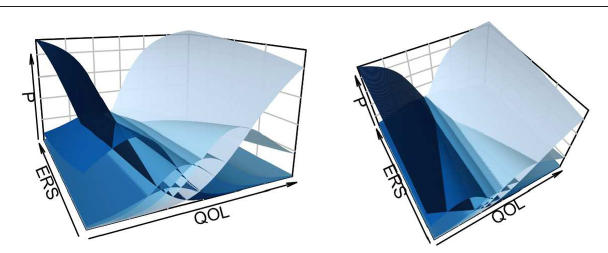
FIGURE 2 | Category response functions for Item 2 from a model with QOL and ERS.